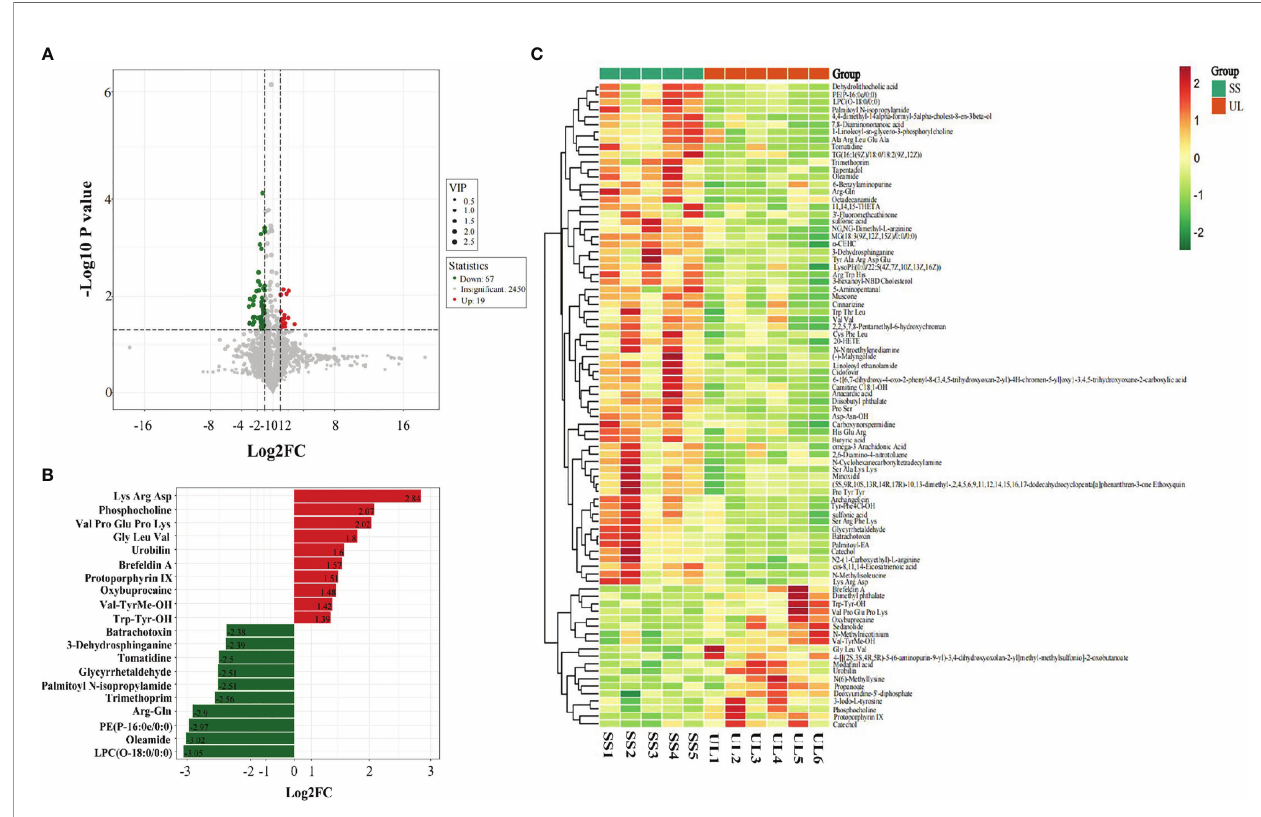
FIGURE 5 | Volcano plot showing differential metabolites between the SS and UL groups (A) . Linear discriminant analysis (LDA) effect size (LEfSe) results showed the top 20 differential metabolites between the SS and UL groups (B) . Hierarchical cluster analysis of differential metabolites between the SS and UL groups (C) . Each column represents a sample, and each row stands for a metabolite. The differential metabolites were identi fi ed using the following criteria: variable importance in projection (VIP) ≥ 1.0, p-value < 0.05 and fold change ≥ 2 or ≤ 0.5. SS: n = 5, UL: n = 6. UL, unilateral labyrinthectomy group; SS, sham surgery